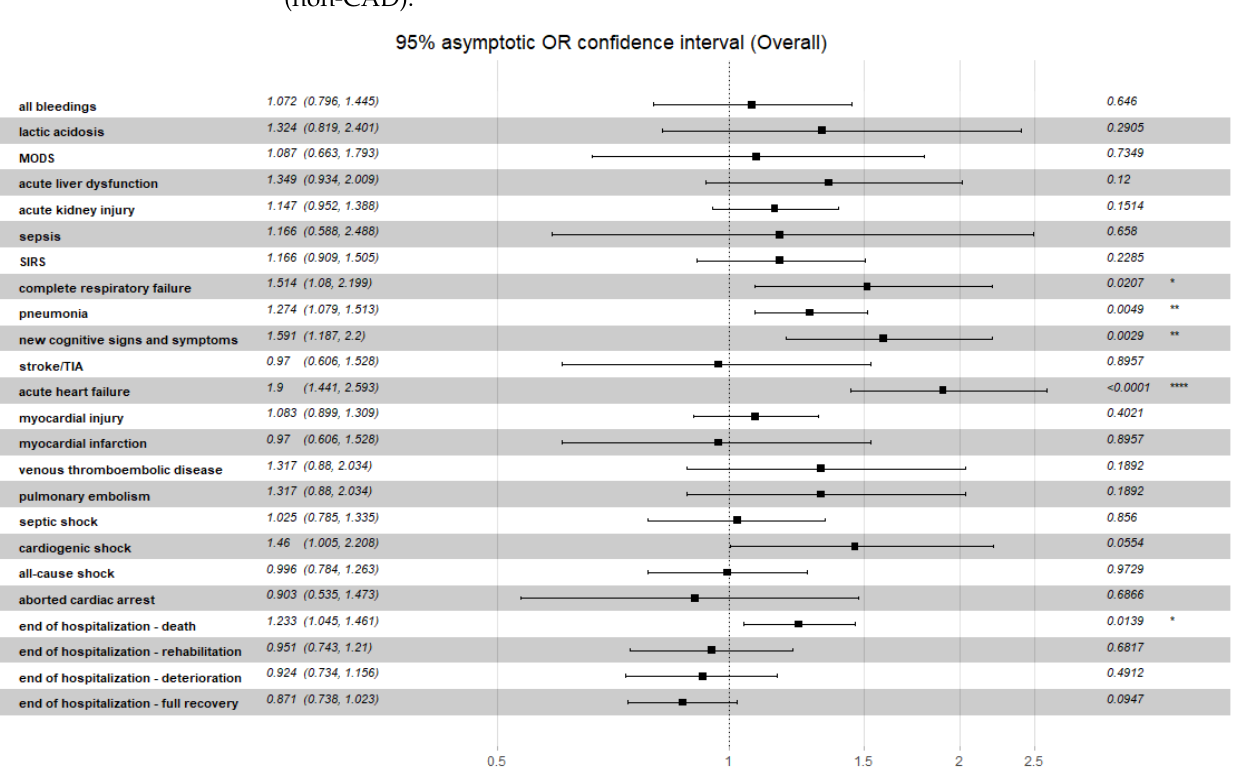
Figure 4. Overall odds ratio for the discriminatory performance of the C 2 HEST score for clinical non-fatal events in CAD cohort. p -value: Significance code. **** p < 0.0001, *** p < 0.001, ** p < 0.01, * p < 0.05.